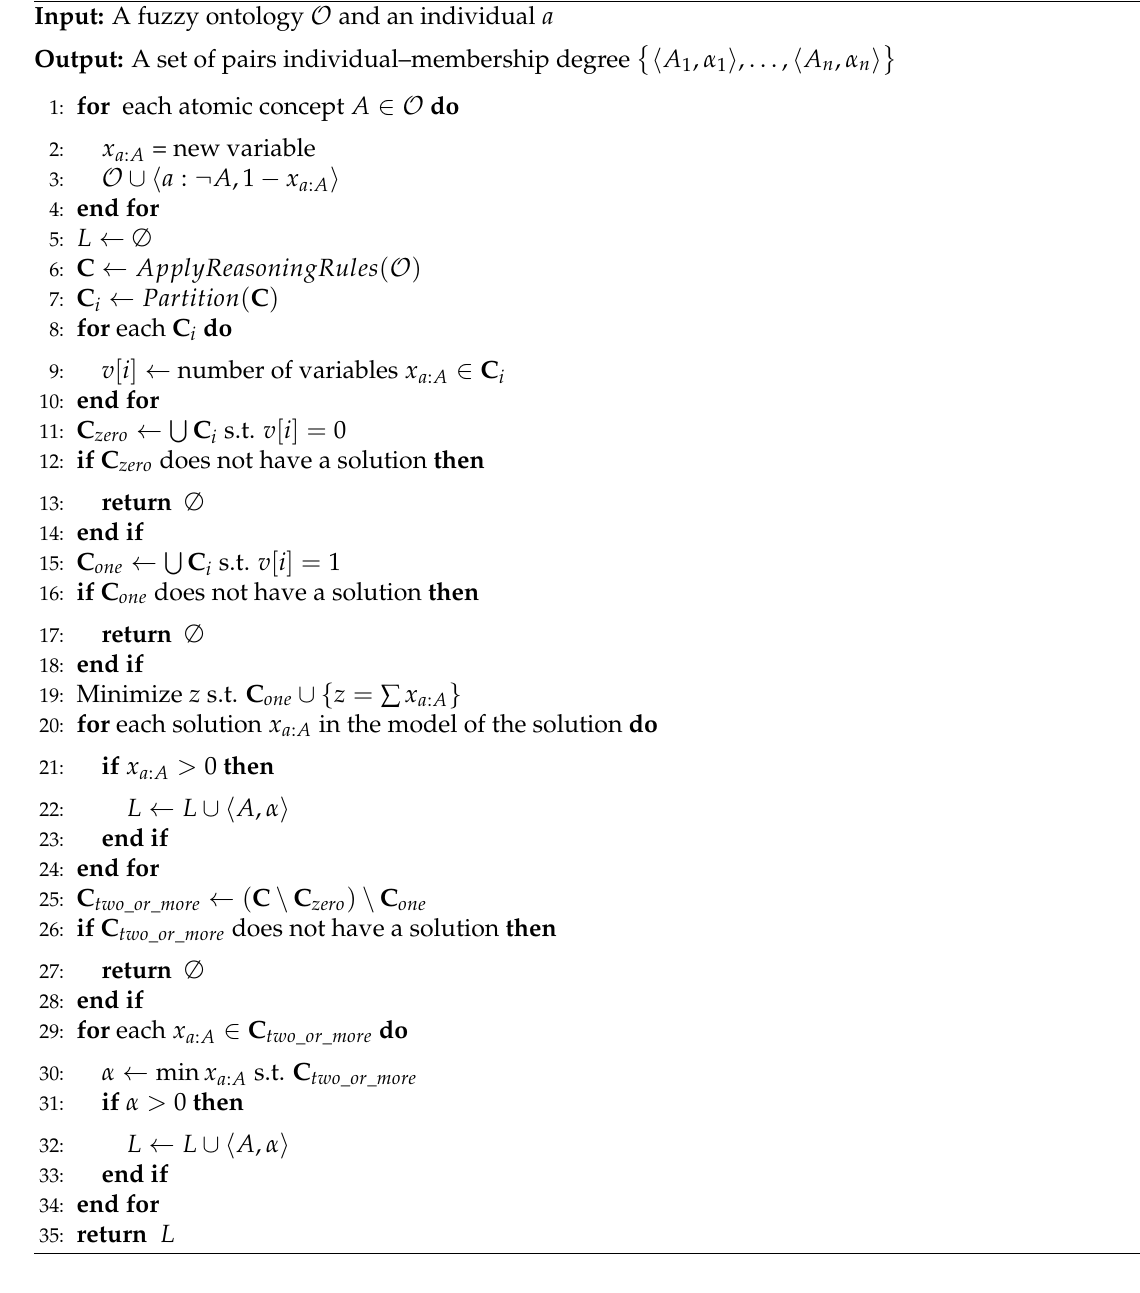
Algorithm 1 Algorithm to compute the realization problem given a fuzzy ontology O